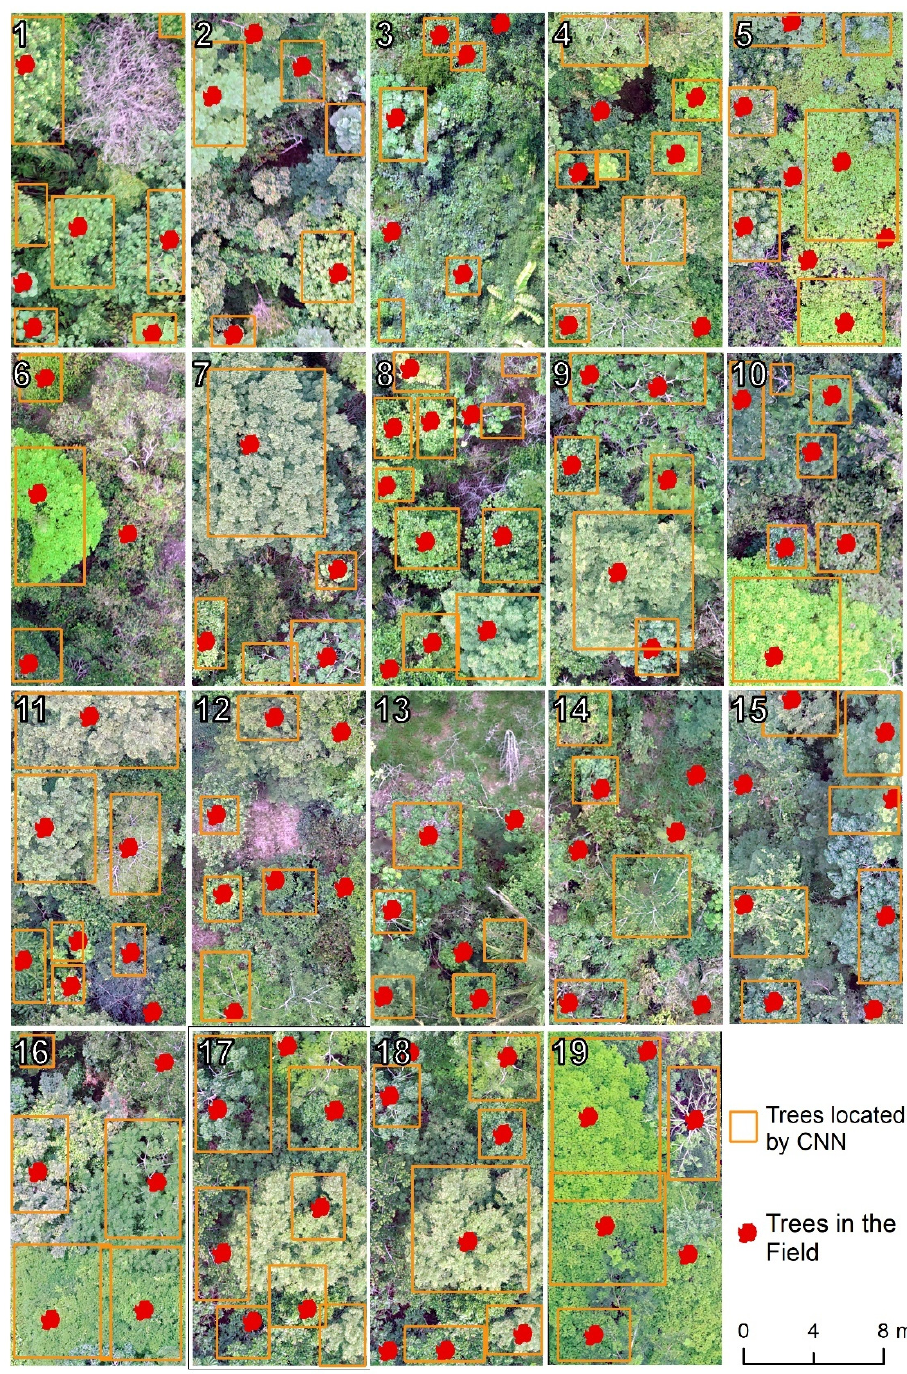
Figure 7. Location of trees from field data and species recognition model.